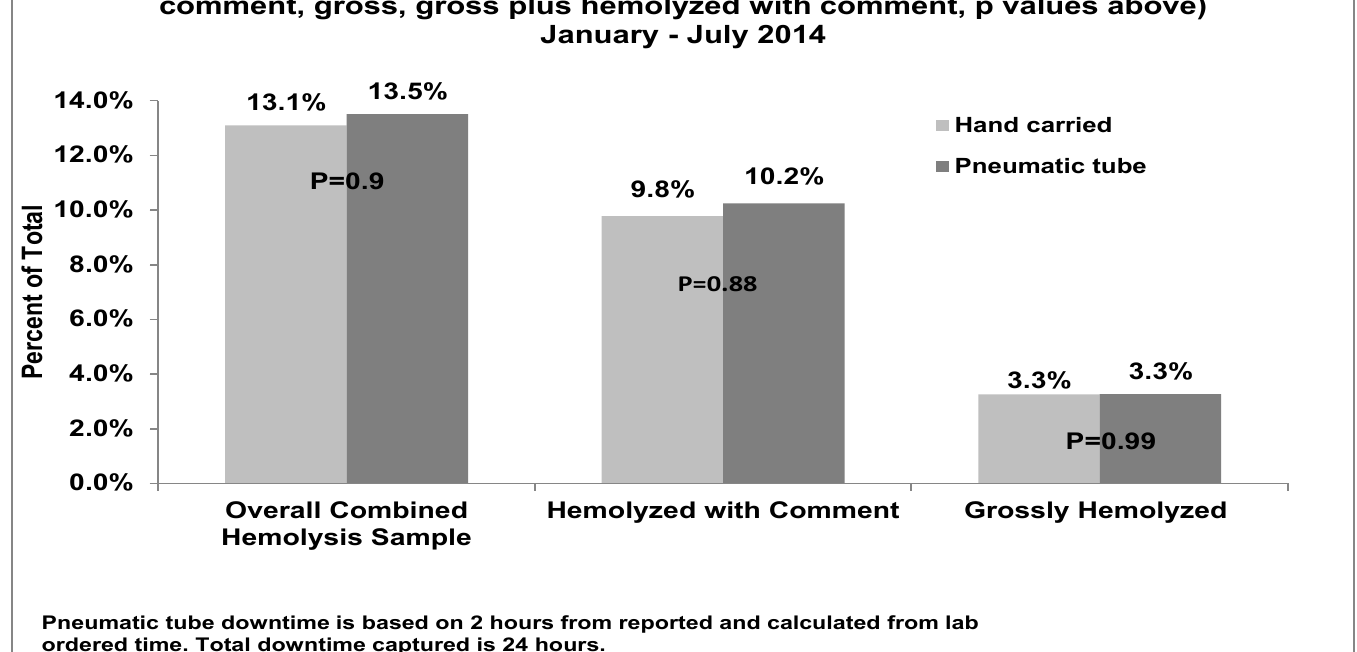
Figure. Comparison of hand carried vs pneumatic tube transported emergency department sample hemolysis January – July 2014. Figure 1. Comparison of hand carried vs pneumatic tube transported emergency